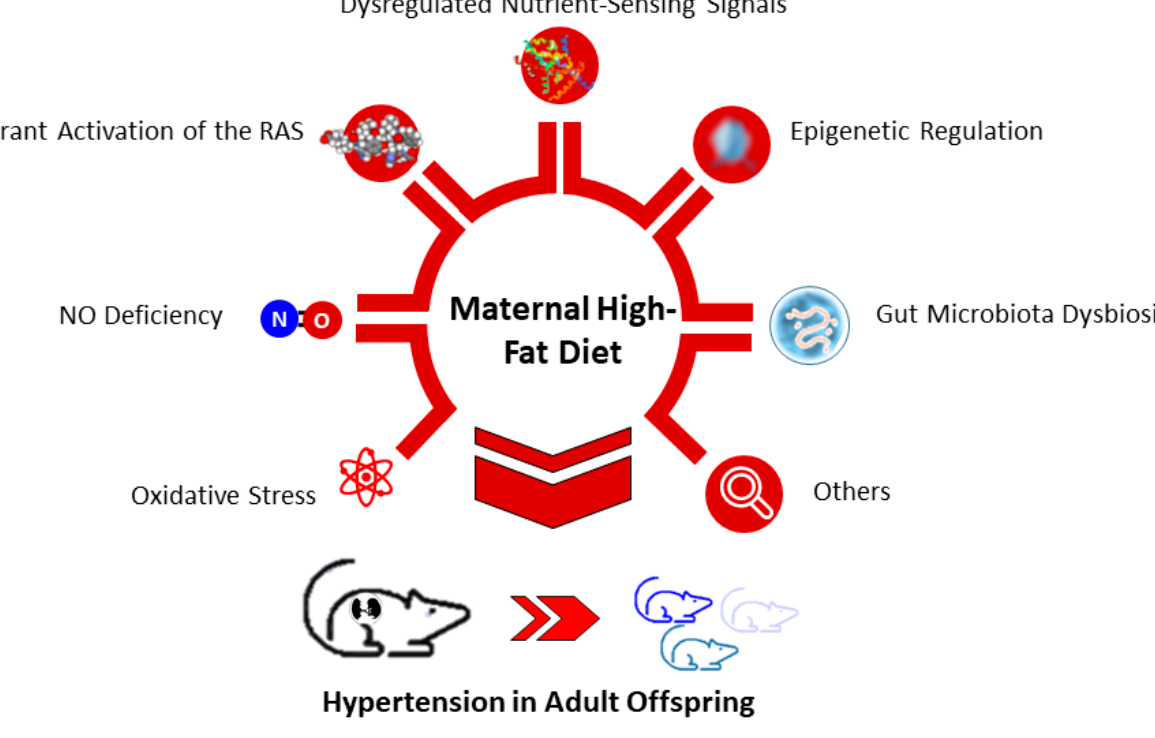
Figure 2. Schematic diagram of the common mechanisms linking maternal high-fat diet to offspring hypertension.